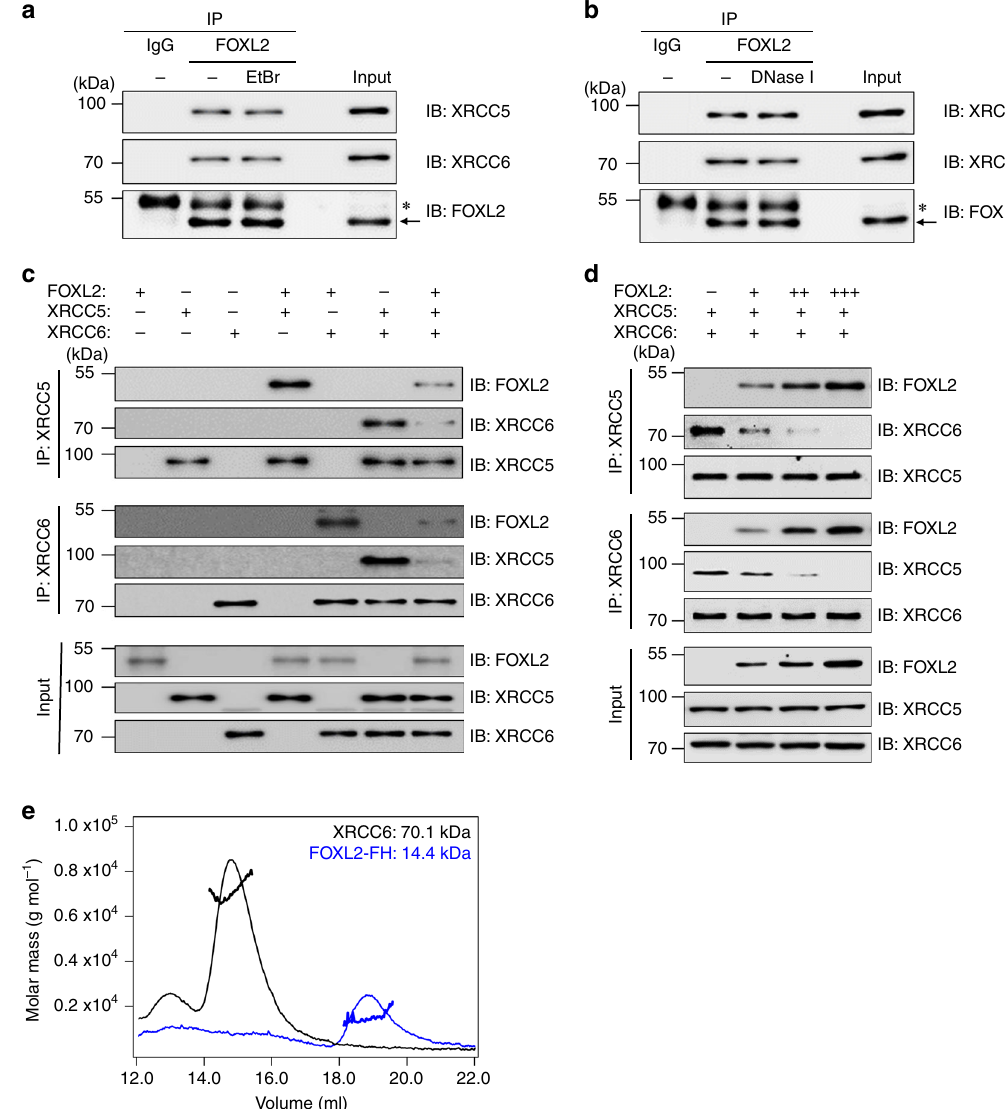
Fig. 2 FOXL2 inhibits Ku heterodimer formation. a , b To determine whether ternary complex formation between FOXL2 and Ku proteins requires the presence of DNA, ethidium bromide (EtBr, 50 μ g/ml) ( a ) or DNase I (10 U) ( b ) were added to KGN lysates, which were subjected to IP using anti-FOXL2 antibody followed by western blotting. c , d In vitro complex formation of FOXL2 with Ku proteins was assessed using puri fi ed recombinant His-tagged FOXL2, XRCC5, and XRCC6 proteins. Following incubation of the indicated proteins (0.3 μ g) ( c ), IP with anti-XRCC5 or anti-XRCC6 antibody and immunoblot analyses with the indicated antibodies were conducted. In addition, increasing amounts (0.15, 0.3, and 0.6 μ g) of FOXL2 protein ( d ) were incubated with equal amounts (0.3 μ g) of XRCC5 and XRCC6 proteins, and IP and immunoblot analyses were conducted. e Monomeric existence of XRCC6 (black line) and FOXL2-FH (blue line) was analysed by SEC-MALS. The thick lines represent measured molecular mass. The expected theoretical molecular mass of monomeric XRCC6 and FOXL2-FH are 70.9 kDa and 13.7 kDa, respectively. Source data are provided as a Source Data fi